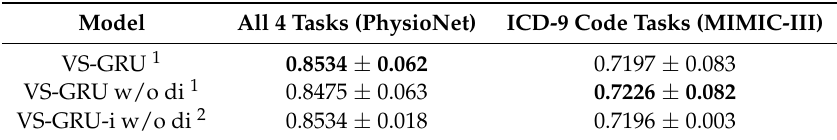
Table 3. Comparison on the multi-label classification problem.